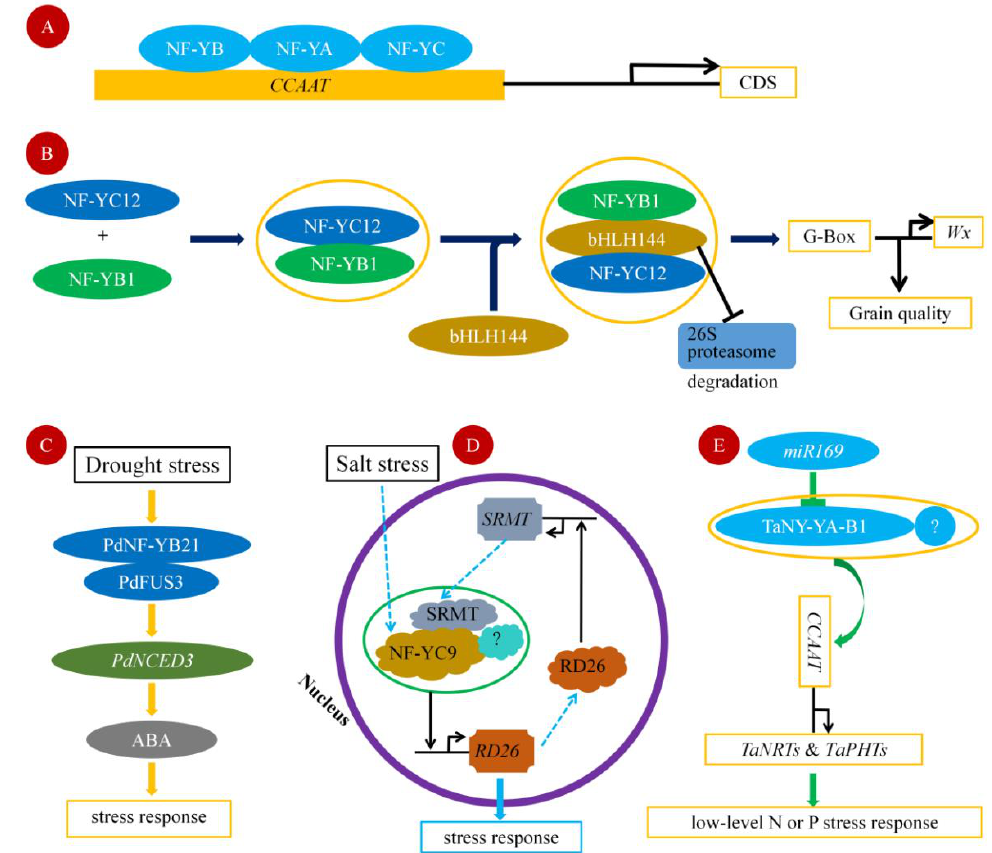
Figure 2. ( A ). A classic NF-Y trimeric complex binds to the CCAAT element. ( B ). NF-YB1 binds with NF-YC12 and bHLH144 in order to form a heterotrimer; the trimer complex protects NF-YB1 from the ubiquitin/26S proteasome-mediated degradation. NF-YB1 activates the expression of Wx to regulate the starch synthesis by directly binding to the G-box. ( C ). Poplar PdNF-YB21 responds to drought stress. ( D ). Poplar NF-YC9 responds to salt stress. ( E ). Wheat TaNF-YA-B1 responds to low phosphorus and low nitrogen.